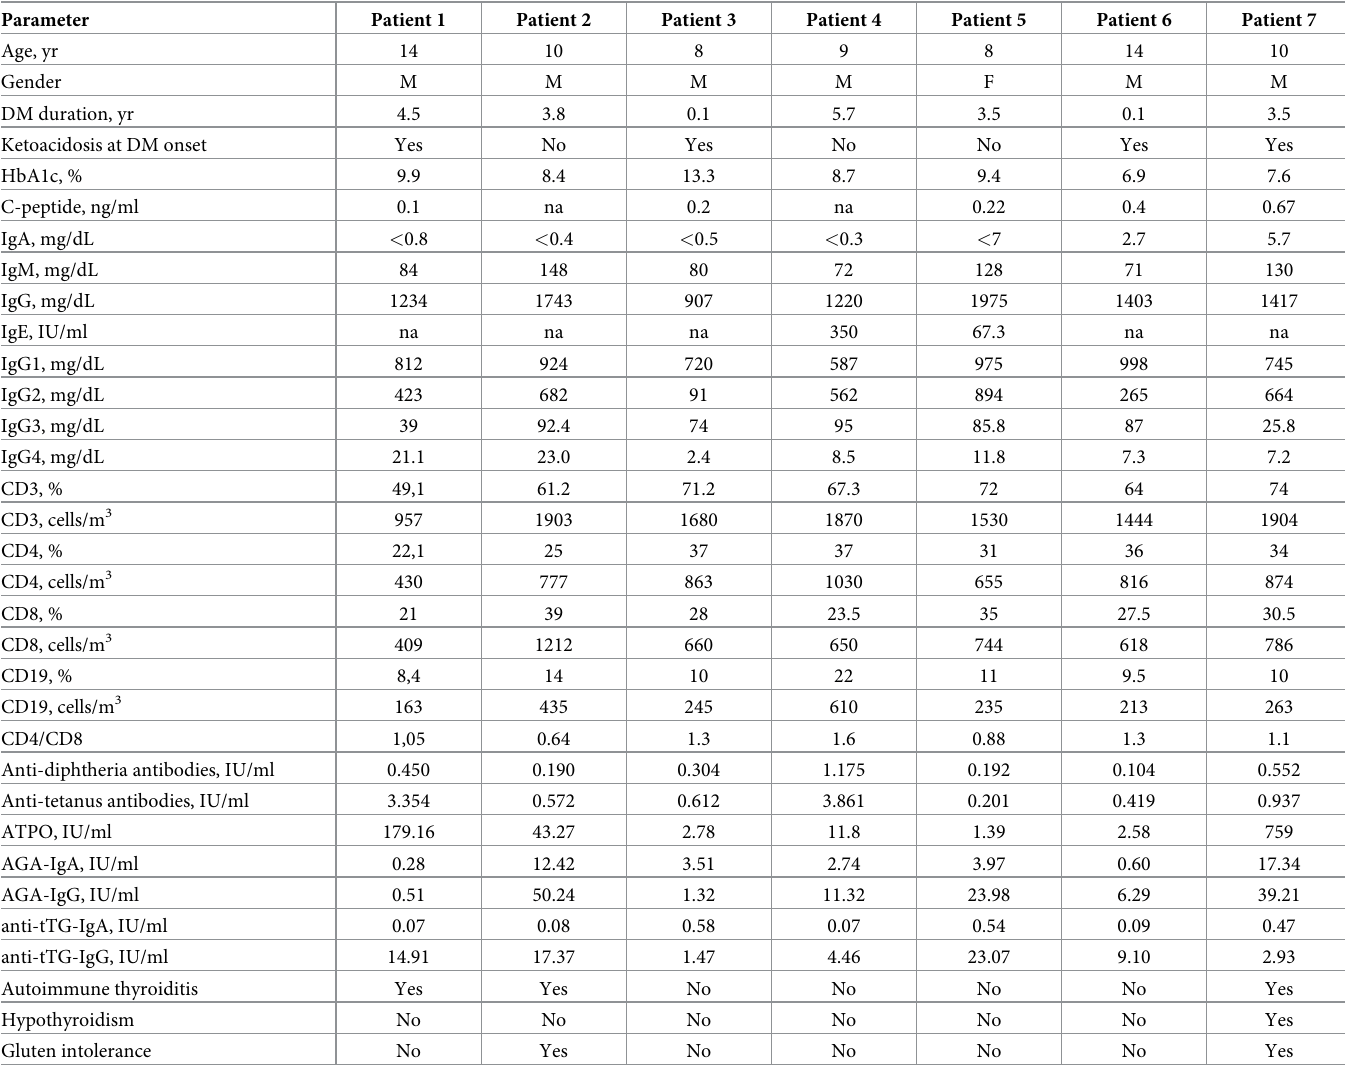
Table 3. Clinical and laboratory data of patients with DM and